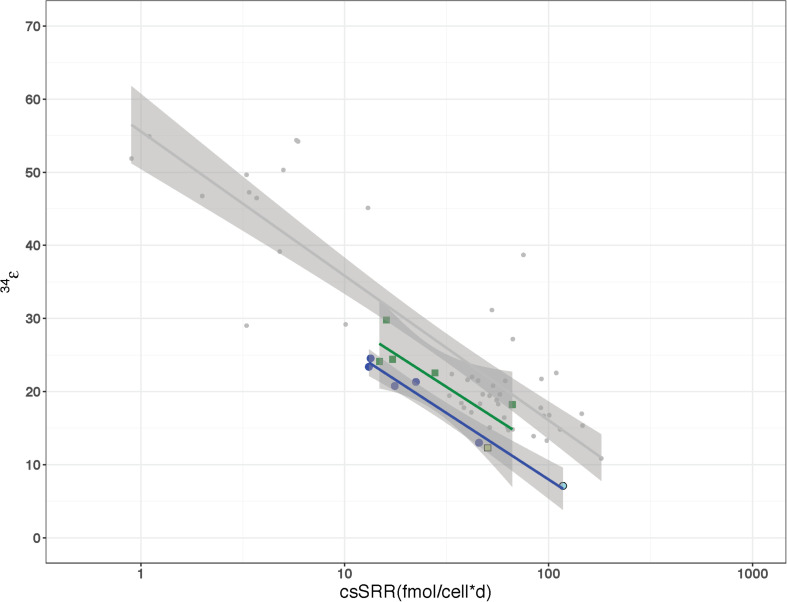
Relationship of cell-specific sulfate reduction rates (csSRR) to sulfur fractionation factor (34ε) for D. vulgaris as previously reported by Leavitt et al. (2013) in comparison to the wild type strain (dark blue) and Δrex (green) grown in continuous and batch culture. The light blue and green colored symbols represent the batch fractionation factors for WT and Δrex, respectively.